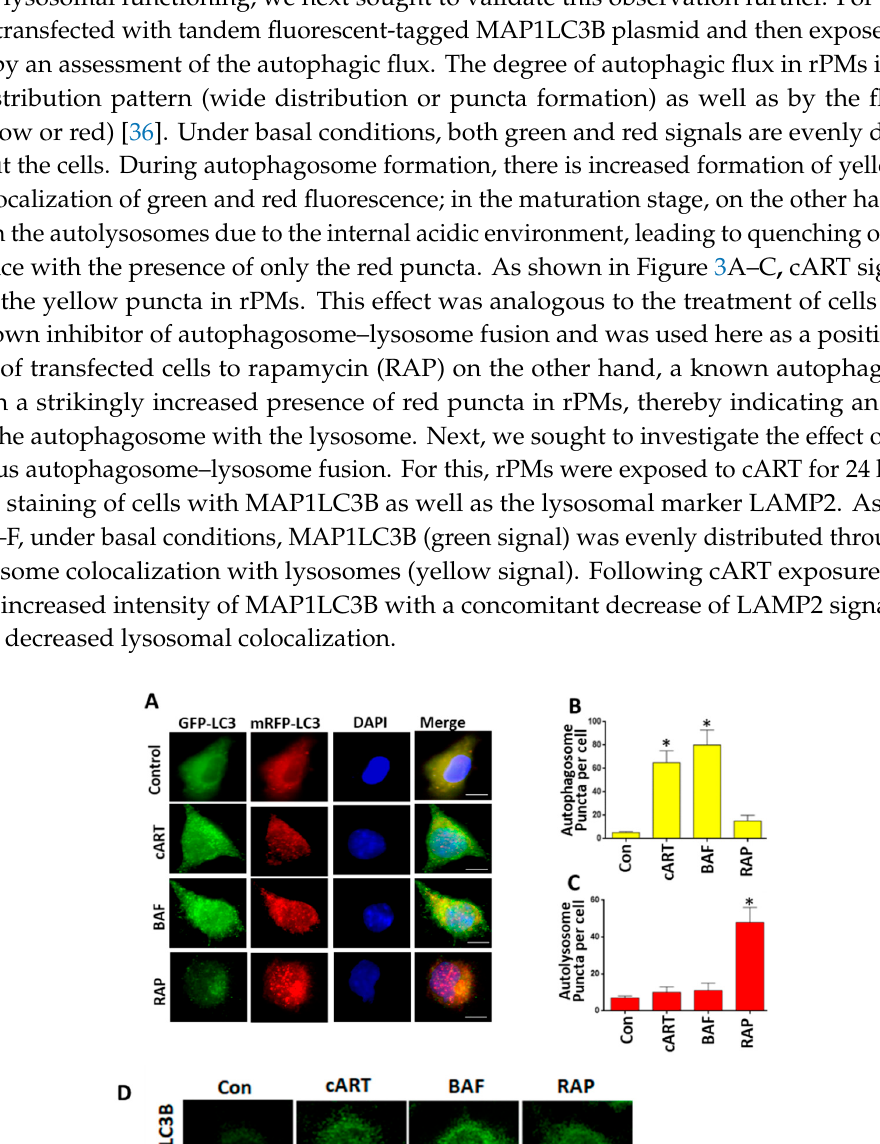
Figure 3. Exposure of microglia to cART resulted in blockade of autophagosome–lysosome fusion. ( A ) rPMs were seeded into a 12-well plate followed by tandem fluorescent-tagged MAP1LC3B plasmid. Next, cells were exposed to cART (5 μ M each of TDF, FTC, and DTG) for an additional 24 h and observed by confocal imaging. The results showed that cART exposure significantly increased the formation of autophagosomes (yellow puncta). ( B ) Representative bar graph showing the number of autophagosome (yellow puncta) per cell. ( C ) Representative bar graph showing the number of autolysosome (red puncta) per cell. ( D ) rPMs were seeded into 12-well plates followed with cART exposure for 24 h. Cells were then double immunostained with MAP1LC3B and LAMP2 antibody and observed by immunofluorescent microscopy. ( E , F ) Representative bar graphs showing cART- mediated decreased LAMP2 puncta and decreased colocalization of MAP1LC3B and LAMP2. BAF— autophagosome fusion inhibitor, and rapamycin (RAP—autophagy inducer) were used as controls for autophagy flux. Data is from three independent experiments and is expressed as means ± SEM and were analyzed using one-way ANOVA. *, p < 0.05 vs. control. 3.4. cART-Mediated Activation of rPMs Moderate activation of microglia plays a role in CNS homeostasis via immunological surveillance; however, prolonged activation mediates neuroinflammation. To explore the effects of cART on microglial activation, rPMs were either left untreated or were exposed to cART (TDF, FTC, DTG), each at 5 μ M for 3 to 24 h. To determine cART-mediated microglial activation, we assessed proinflammatory cytokine levels in rPMs. Increased levels of proinflammatory cytokines are the determinant of microglial activation. We sought to determine the expression levels of various pro- and anti-inflammatory mediators in the control and cART-treated rPMs. For that, total RNA was